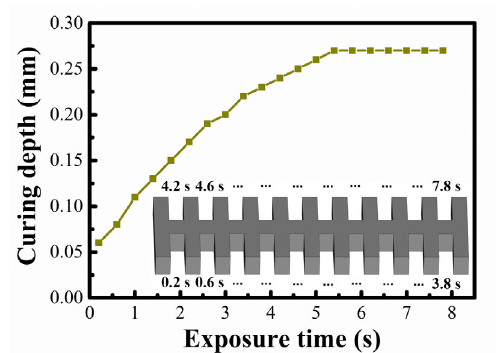
Fig. 4 Curing depth vs. exposure time and the model used to test exposure